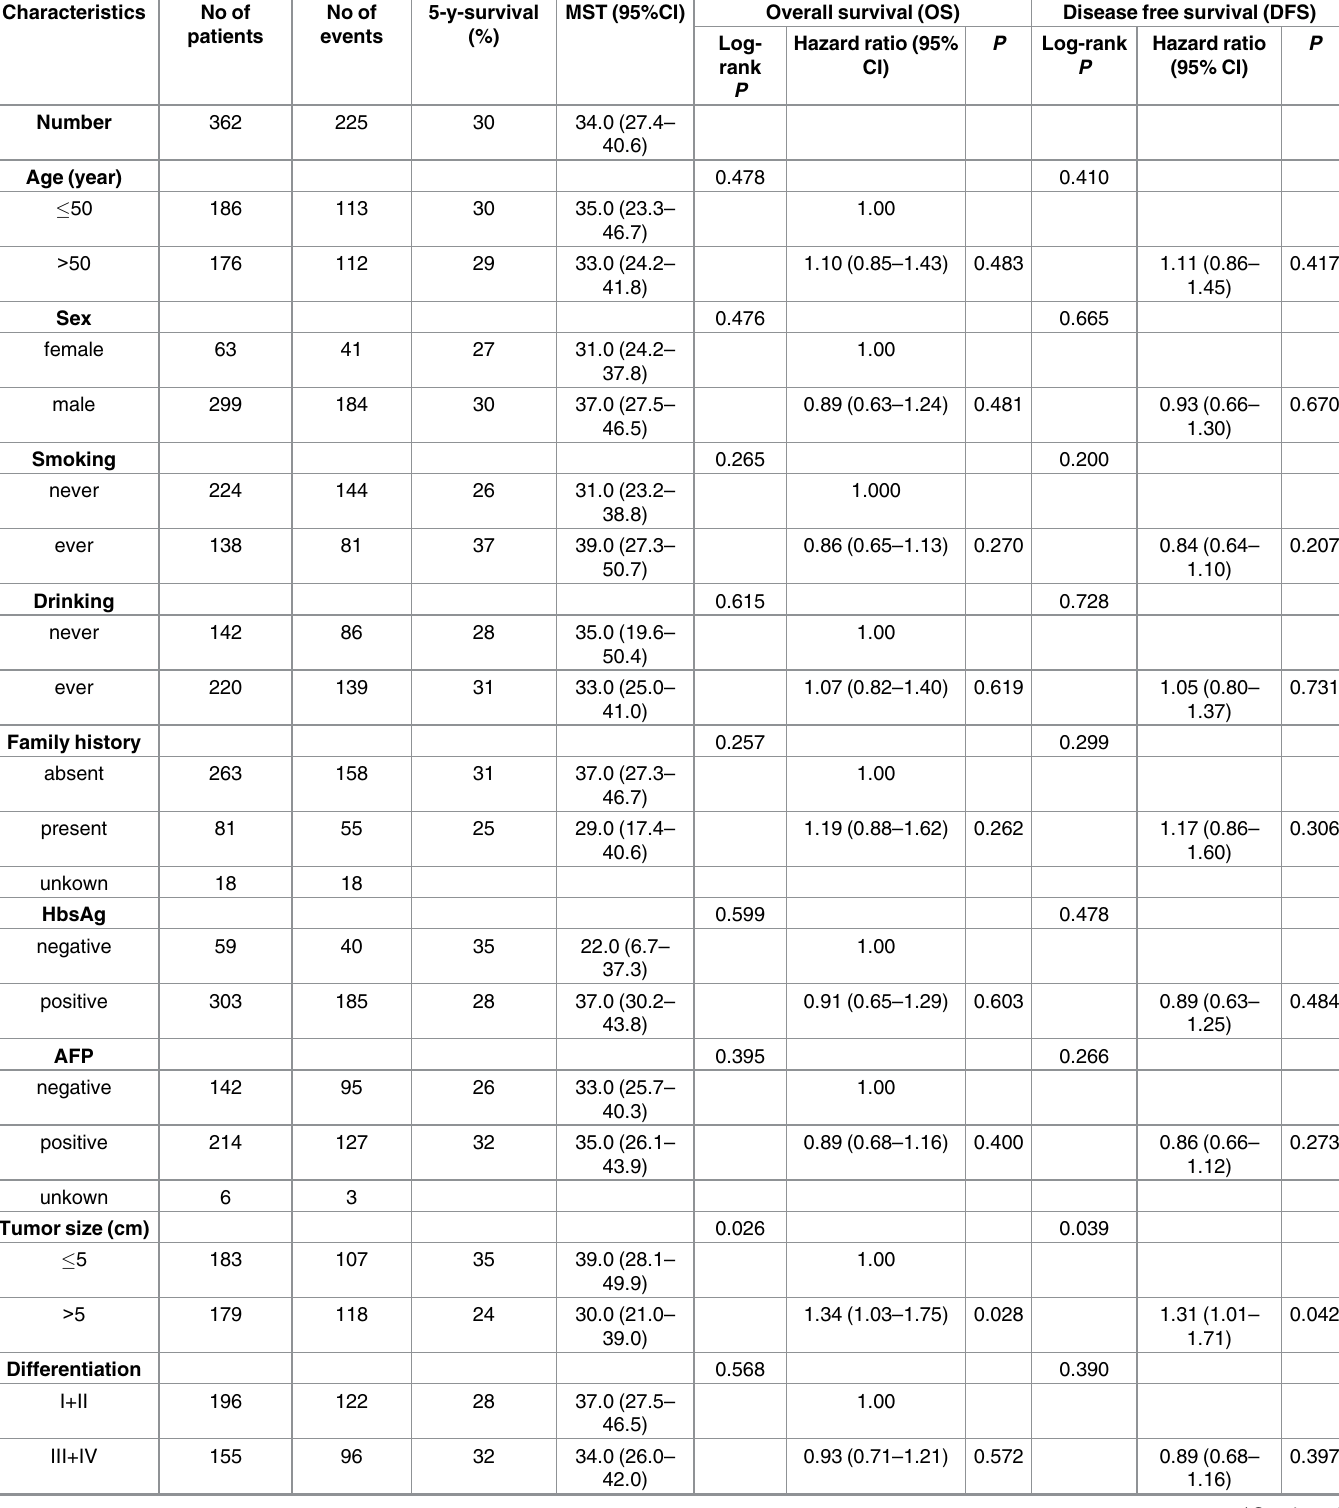
Table 2. Clinical characteristics and their prediction of overall survival and disease free survival in HCC